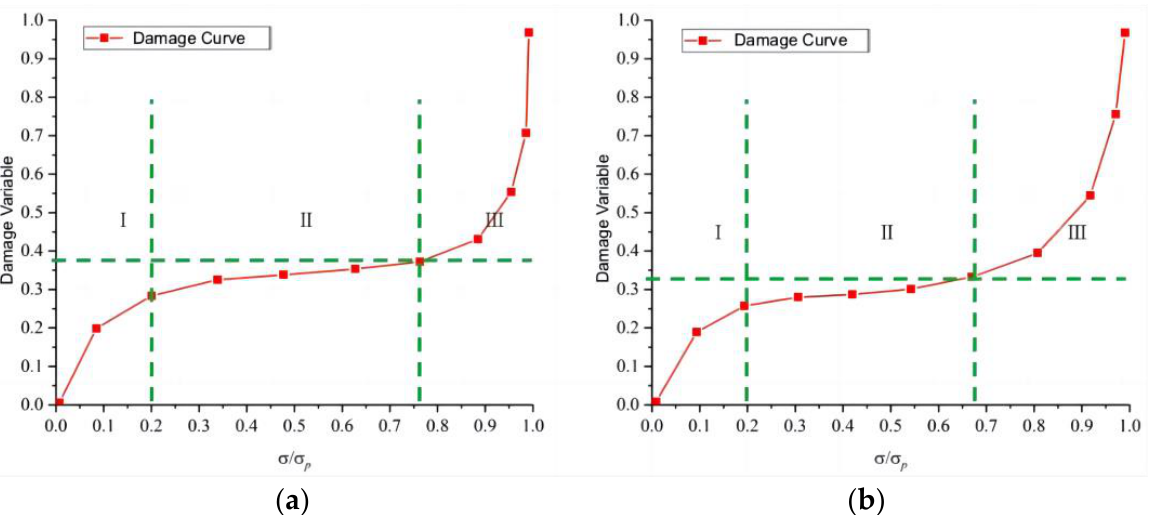
Figure 11. The damage variable evolution of the coal specimen in the fracture process. The green line is used to delineate the different stages through which the coal samples in the diagram have gone. ( a ) The damage variable evolution of the coal sample S1. ( b ) The damage variable evolution of the coal sample S2.